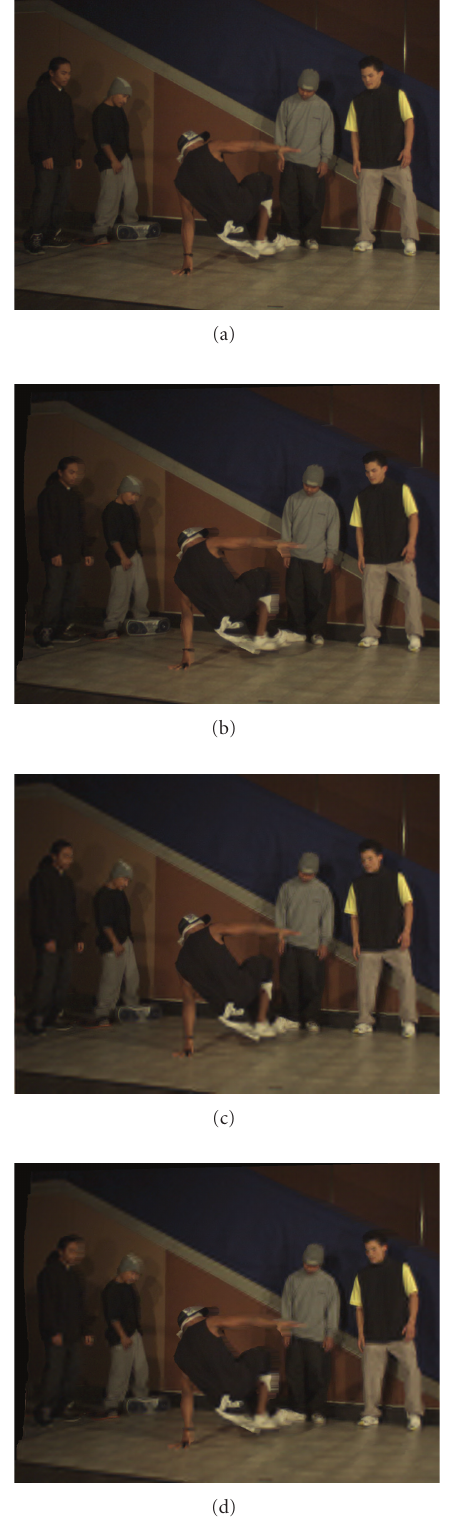
Figure 14: Breakdance : (a) first frame of camera 4, (b) warping of the frame to the viewpoint of camera 3, (c) first frame of camera 4 corrupted by texture packet losses, (d) warping of the corrupted frame to viewpoint 3.